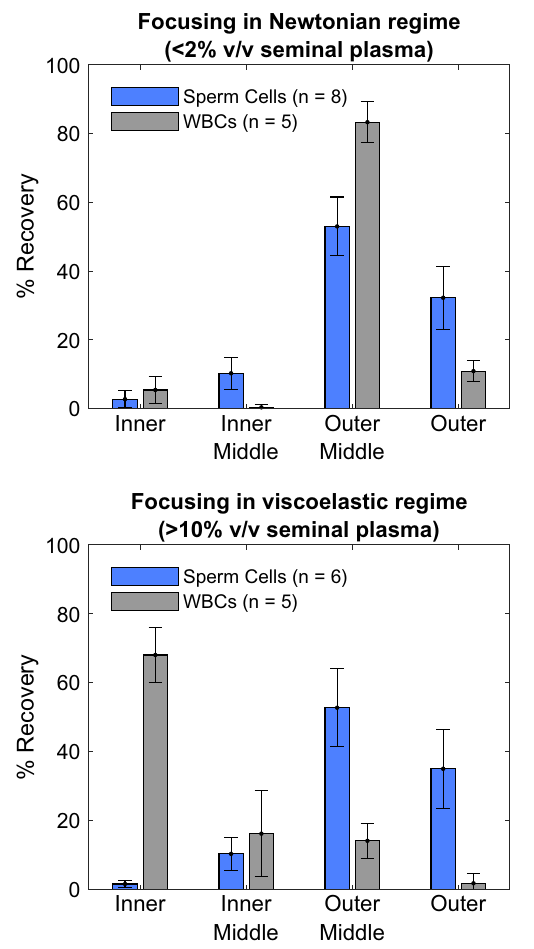
Figure 4. Focusing of sperm cells (blue) and WBCs (grey) in the viscoelastic and Newtonian regimes across 4 outlets. Each outlet represents 25% of the channel width. Recovery percentages are reported relative to the total number of recovered cells. All data represent the mean value of the tests, with the error bars representing the standard deviation amongst the tests. Eight samples were processed in the Newtonian regime, of which five included white blood cells. Six samples were processed in viscoelastic regime of which five had